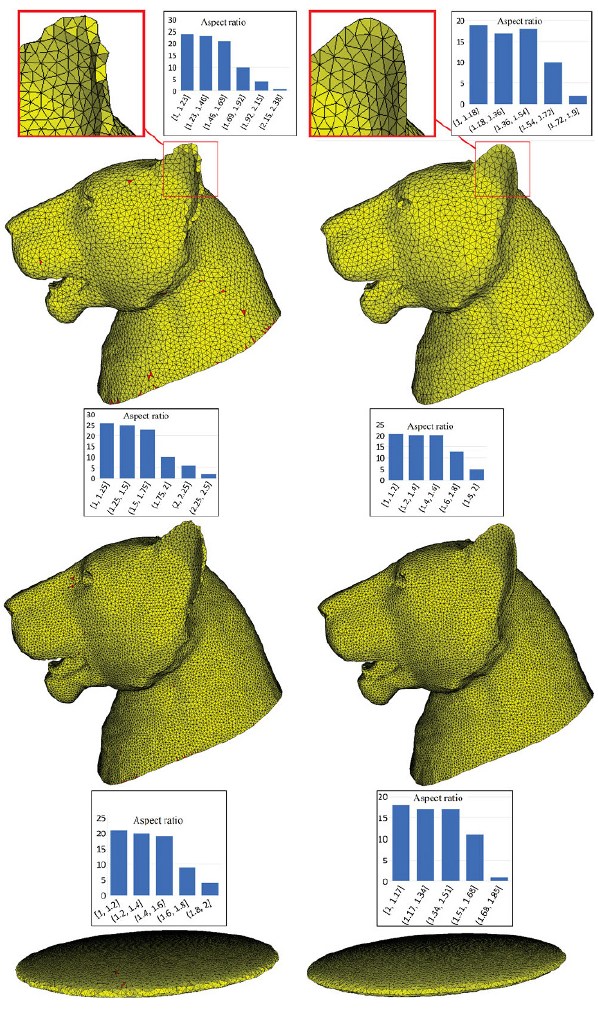
Fig. 7 Remeshing results, uniform density. Triangles with small angle ( < 30 ◦ ) are shown in red. Left: RAR results. Right: Our results.